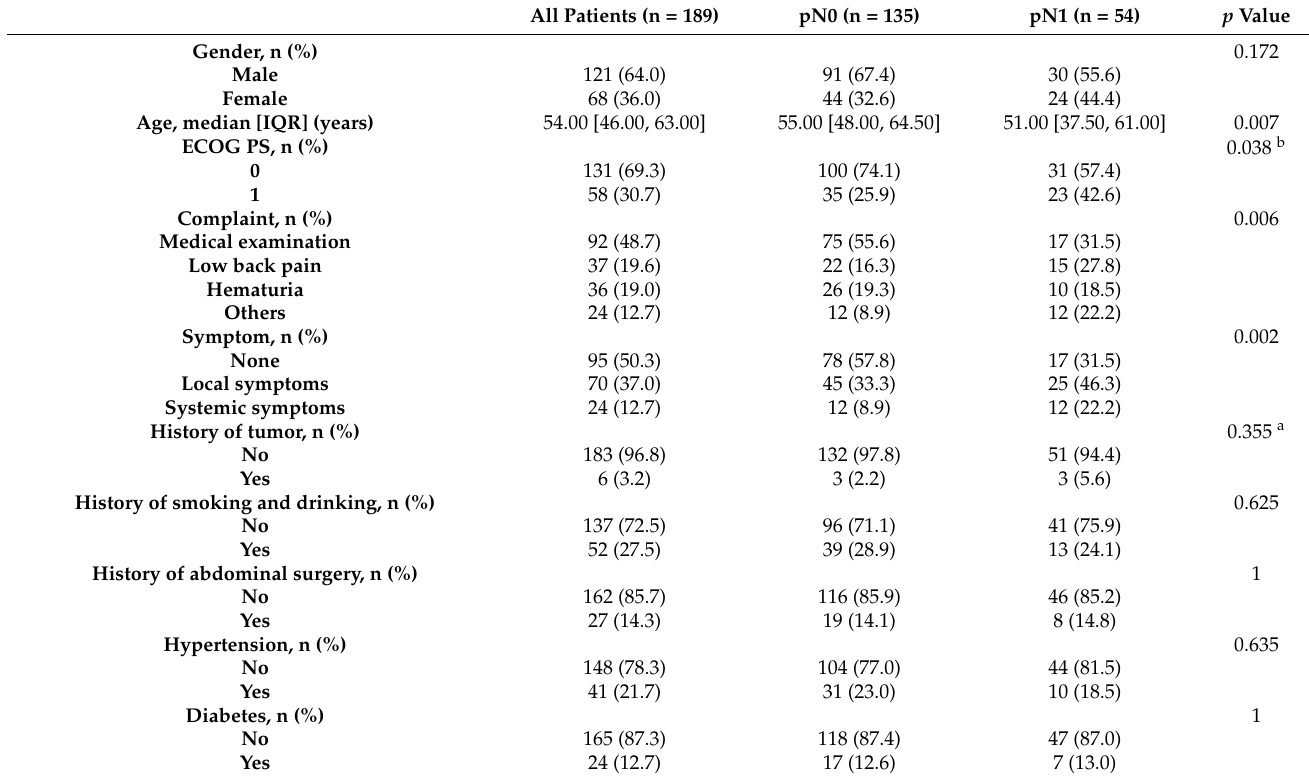
Table 1. Basic characteristics of including